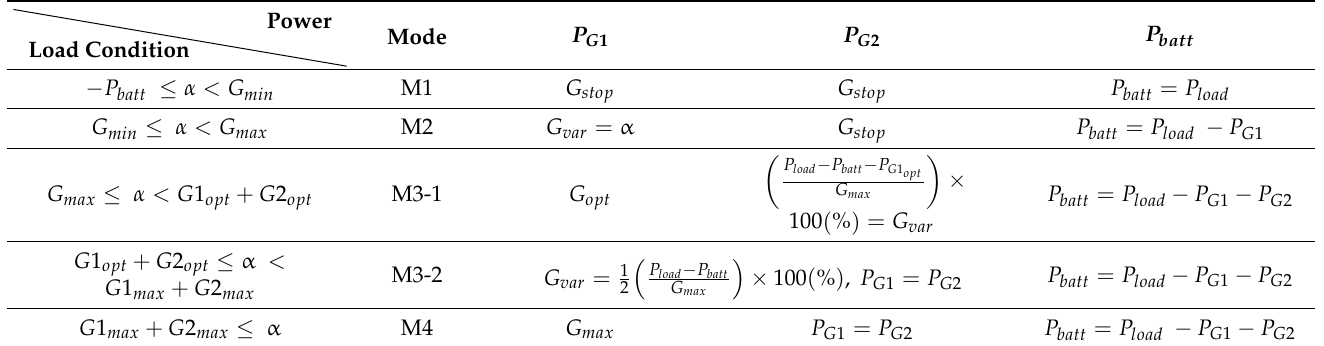
Table 1. Proposed load-sharing